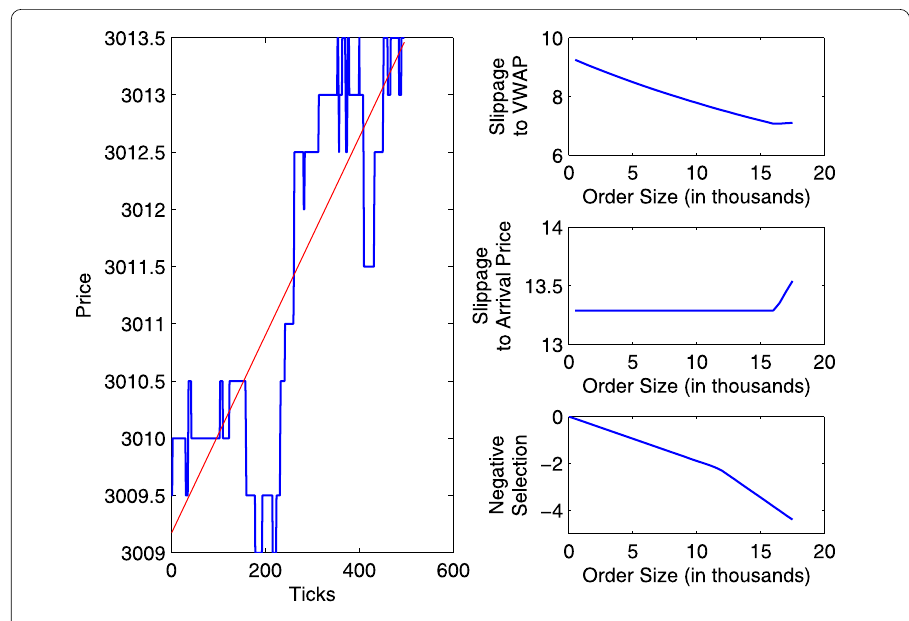
Figure 2 VWAP, Arrival Price and Negative Selection for rising